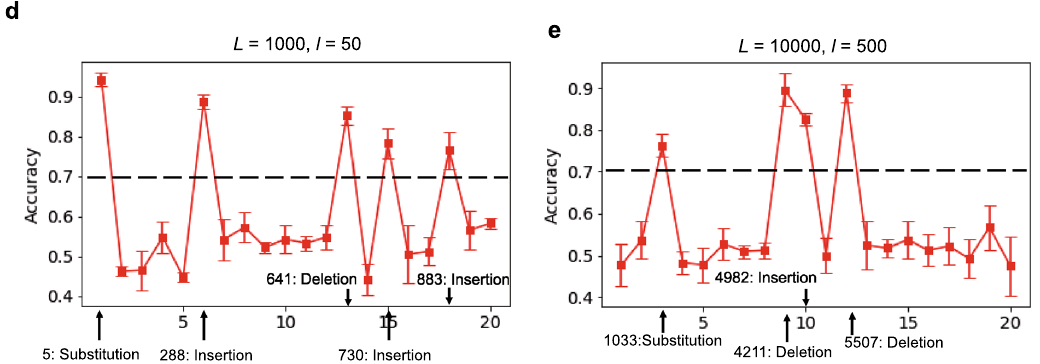
Figure 5. Mutation Region Detection. We use the synthetic experiments to show how our method works. ( a ) shows the process of the synthetic experiments. In the experiment, we first generate the original random RNA sequence of length L / nt , then we set the mutation probability of each nucleotide site on the original sequence to p to generate 2 N mutated sequences. We assume that three common mutation types (i.e., substitution, insertion and deletion) occur with equal probability. Then we divide these 2 N sequences equally into 2 groups, in the first group, we do not perform any processing, while in the second group, we randomly add the same new mutations to them (i.e., add the same mutation on the same nucleotide site). Then we use our mutation region detection algorithm (set the region length to l / nt ) to detect the regions that have mutations, and apply the alignment algorithm on these regions to find the specific mutation. (b-e) We also take the examples with 4 different combinations of sequence length L and region length l : ( b ) L = 1000, l = 100 ; ( c ) L = 10000, l = 1000 ; ( d ) L = 1000, l = 50 ; ( e ) L = 10000, l = 500 . We set the mutation probability p to 5% , and the number of sequences in each group to 100, then we randomly add 5 mutations on the sequences in the second group, and detect the mutation region by using our mutation region detection